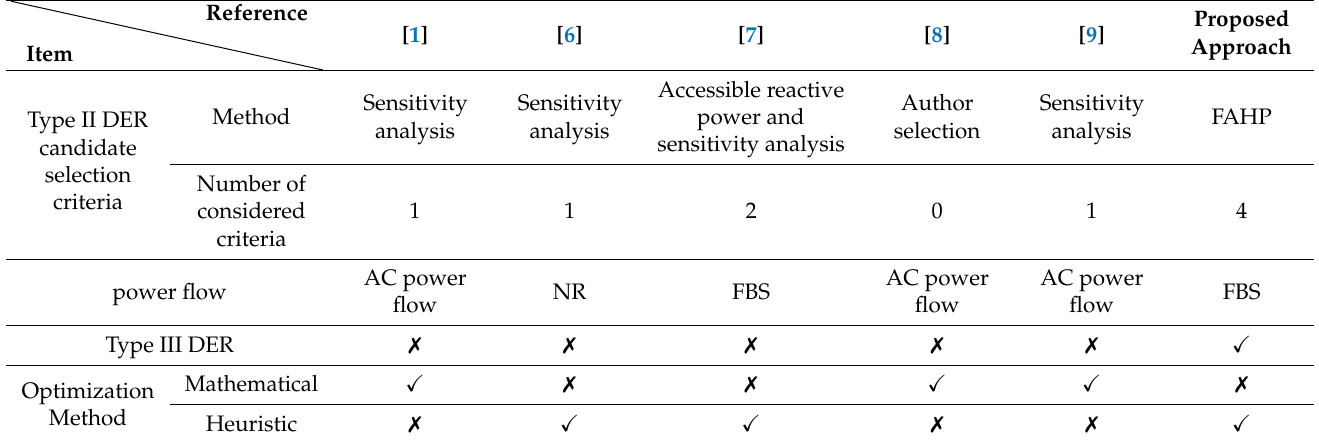
Table 5. The comparison of the proposed method with other methods.